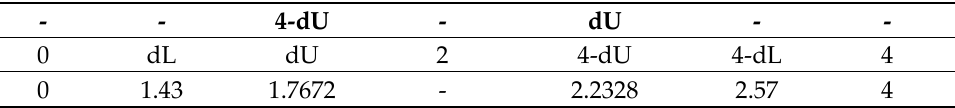
Figure 16. Acceptable values.